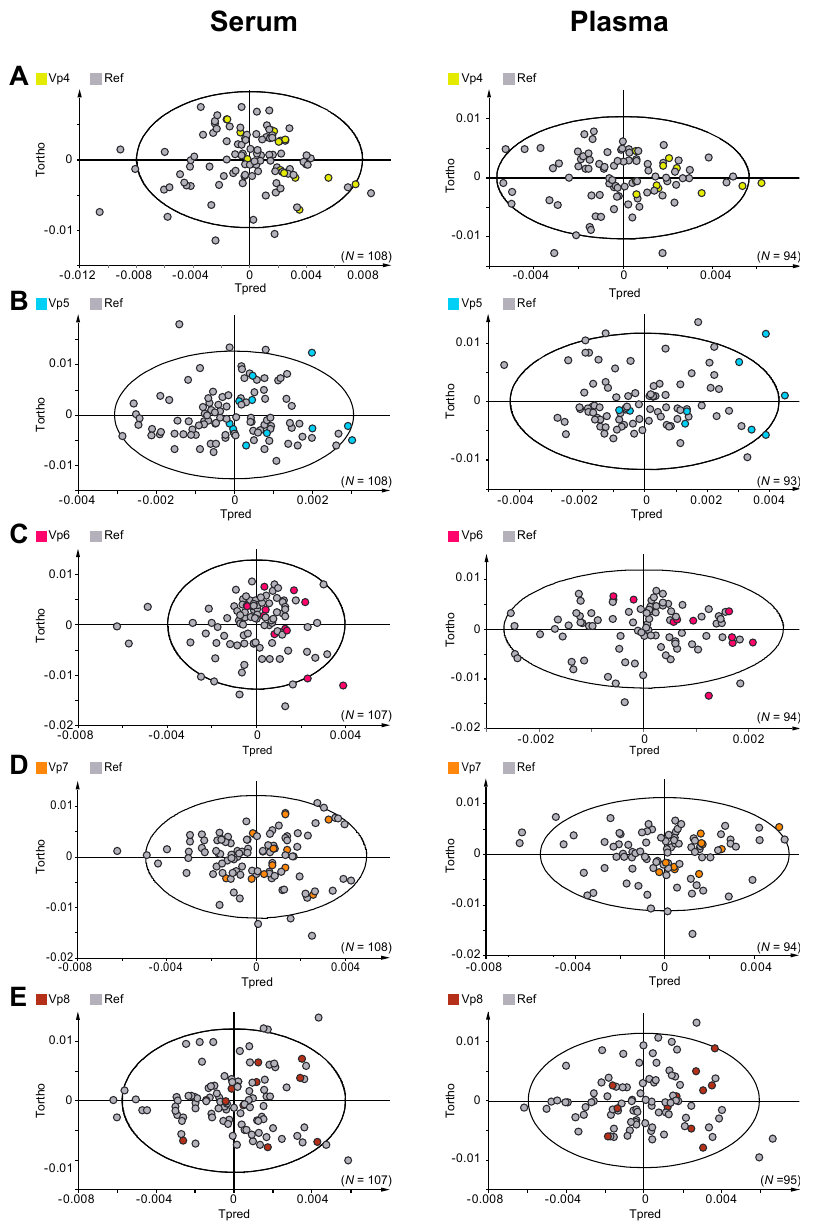
Figure 2. Discrimination between variant protocol samples (Vp4, 5, 6, 7, and 8) and reference protocol samples. ( A ) OPLS models for serum cohort, discriminating Vp4 vs. Ref samples ( N =